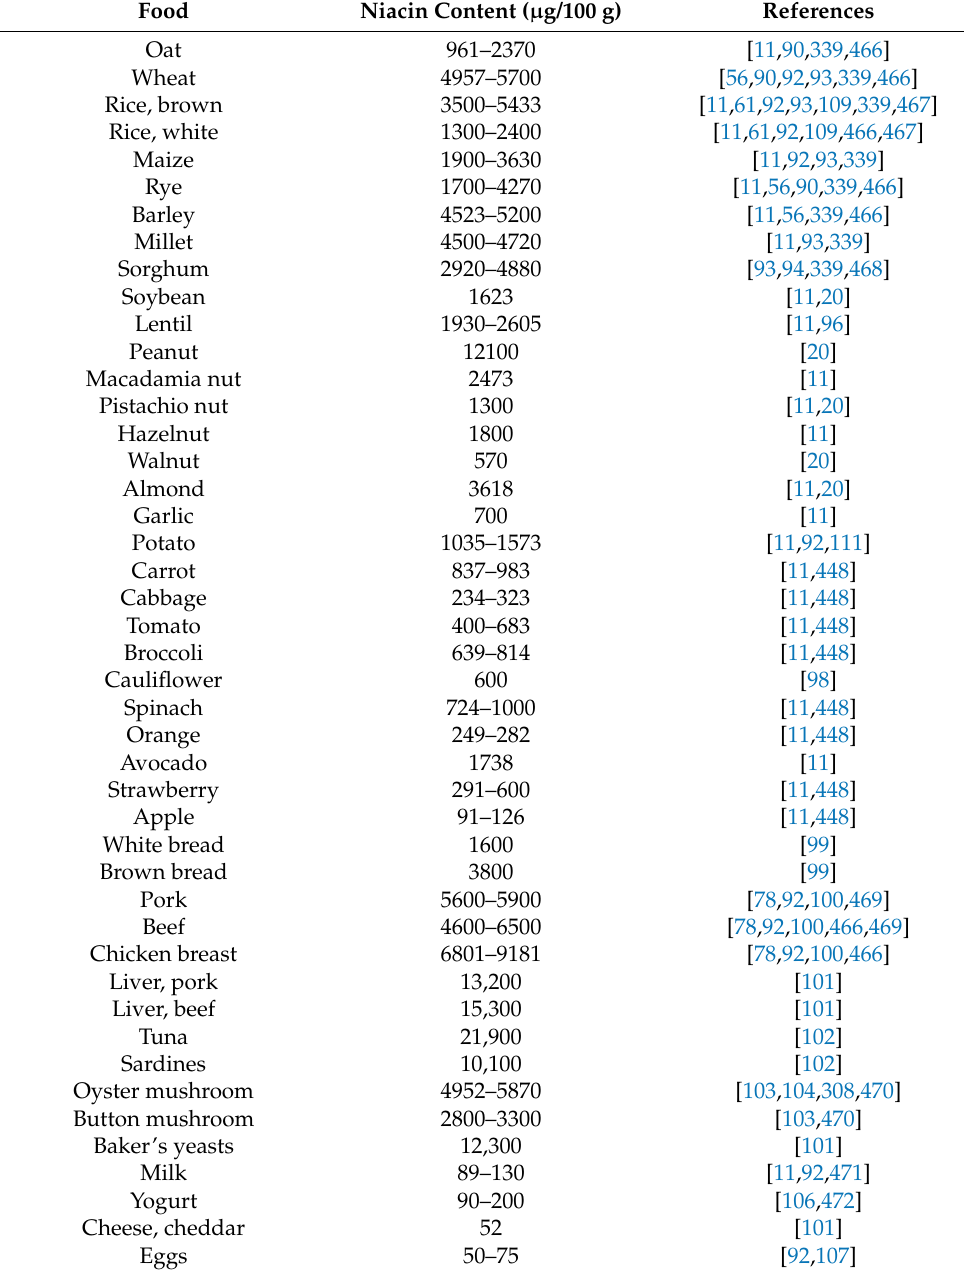
Table 8. Niacin contents in selected